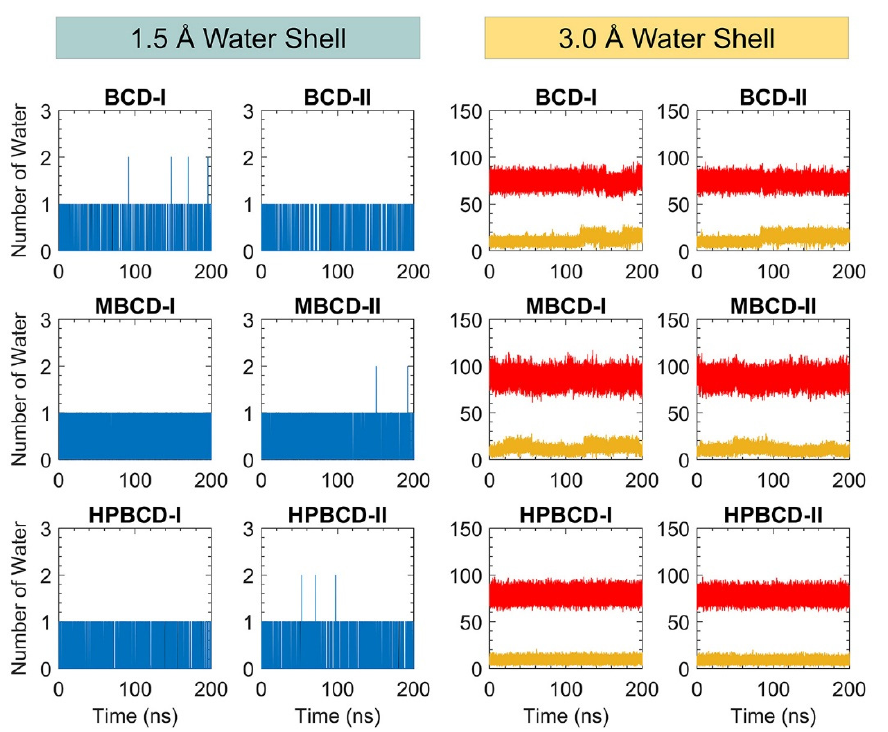
Figure 7. The plot of water molecule counting within defined spherical water shells (1.5 and 3.0 Å) around BCDs and plumbagin molecule throughout 200 ns. The blue and black lines represent the number of water molecules within 1.5 Å water shell around BCDs and plumbagin molecules, respectively. The red and yellow lines represent the number of water molecules within 3.0 Å water shell around BCDs and plumbagin molecules,